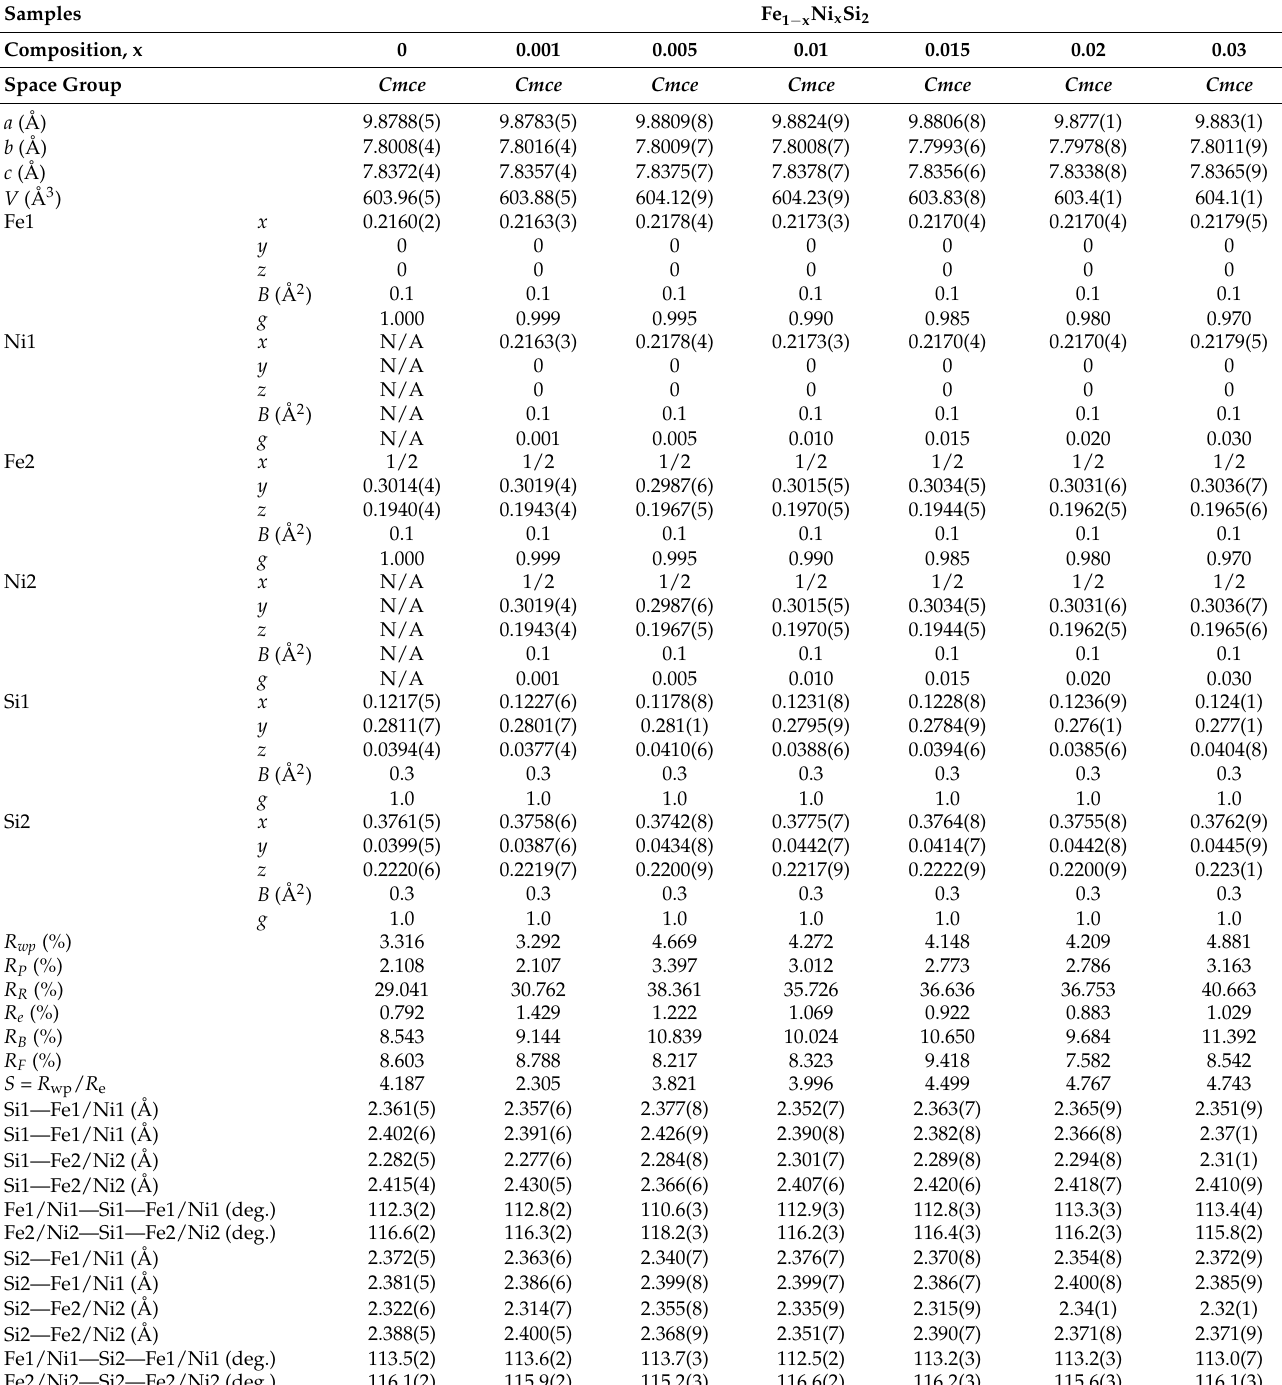
Table A1. Crystal-structure parameters of β -Fe 1 − x Ni x Si 2 (0 ≤ x ≤ 0.03) at room